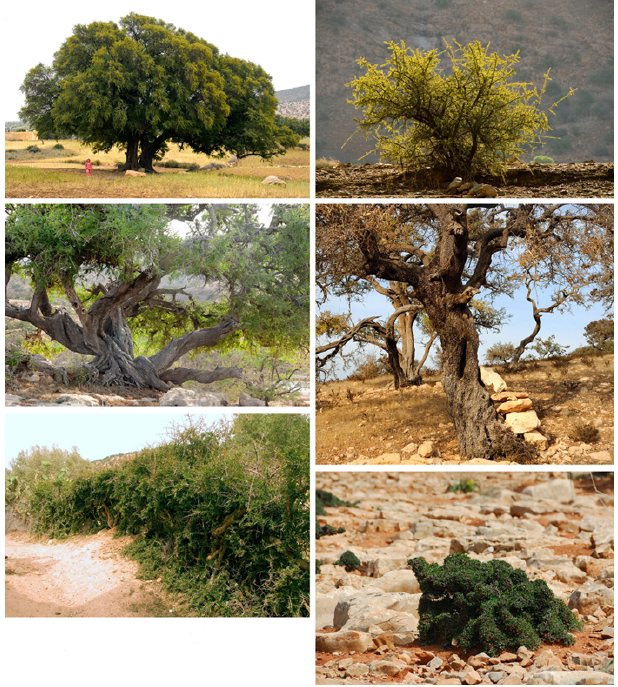
Fig. 4 . Domesticating the argan tree: Umbrella-shape for argan trees in fields (above left), Several stems in collective rangelands (above right), forage tree in family rangelands (middle left) with stone “stairs” (middle right), hedges in villages and fields (below left), “Green-Rock” in collective rangelands (below